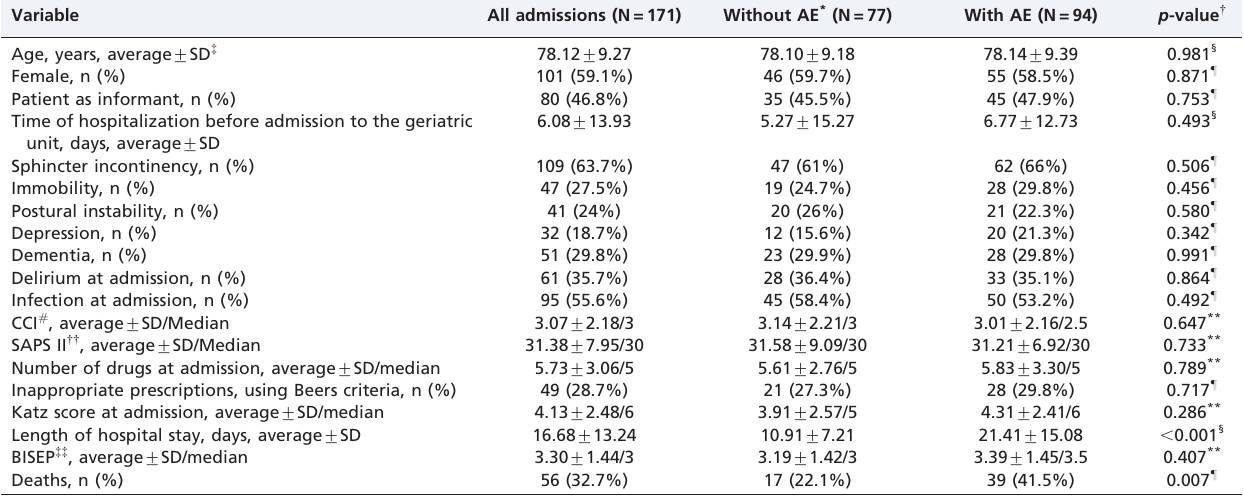
Table 1 - Patient characteristics with and without medical adverse